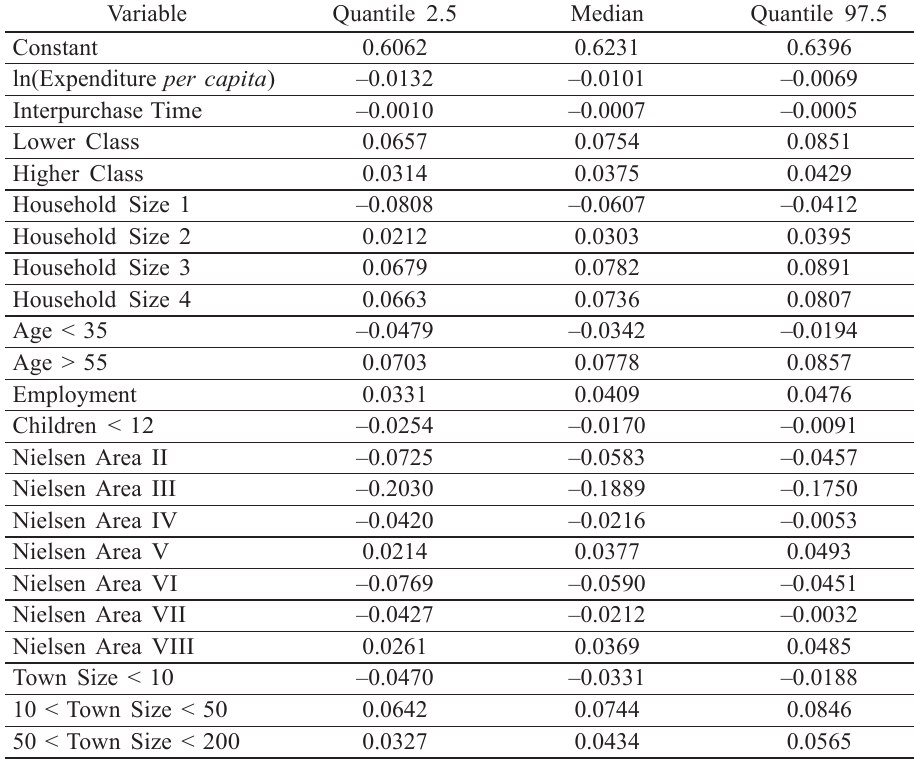
Table 5. Estimation of the parameters of the model